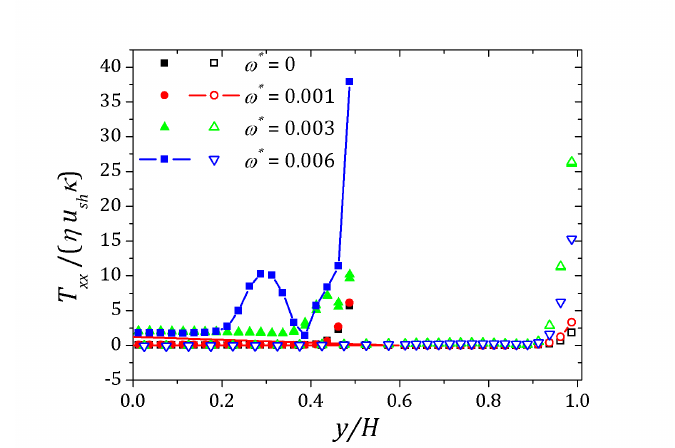
Figure 25. Normal stress into the contraction and right after the expansion of the channel. Results for De κ = 2.5, ε = 0.1 and perturbation parameter ω ∗ = 0, 1.0 × 10 − 3 , 3.0 × 10 − 3 and 6.0 × 10 − 3